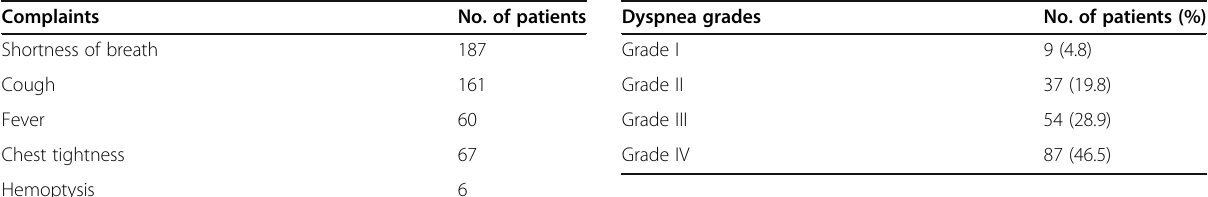
Table 6 Distribution based on dyspnea grades